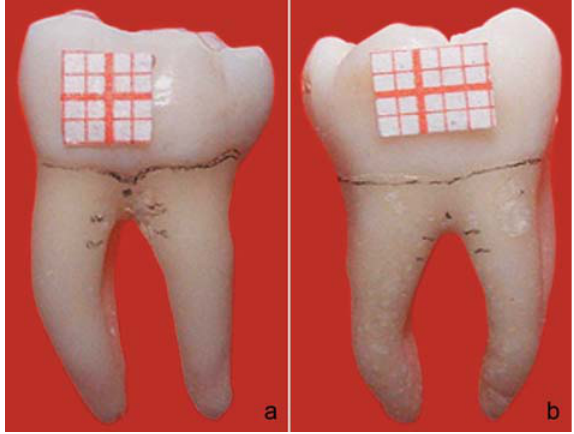
Figure 1- Buccal (a) and lingual (b) surfaces of a mandibular molar with line and reference points